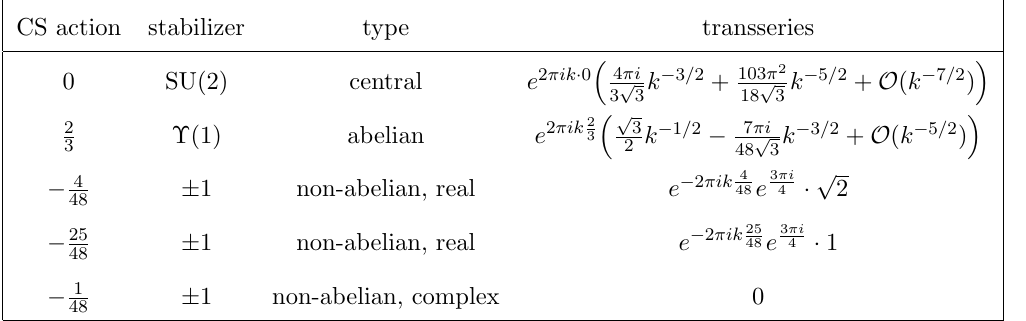
1; 1 ; 1 ; 1 ) up to an overall 3 3 4 (cid:0)